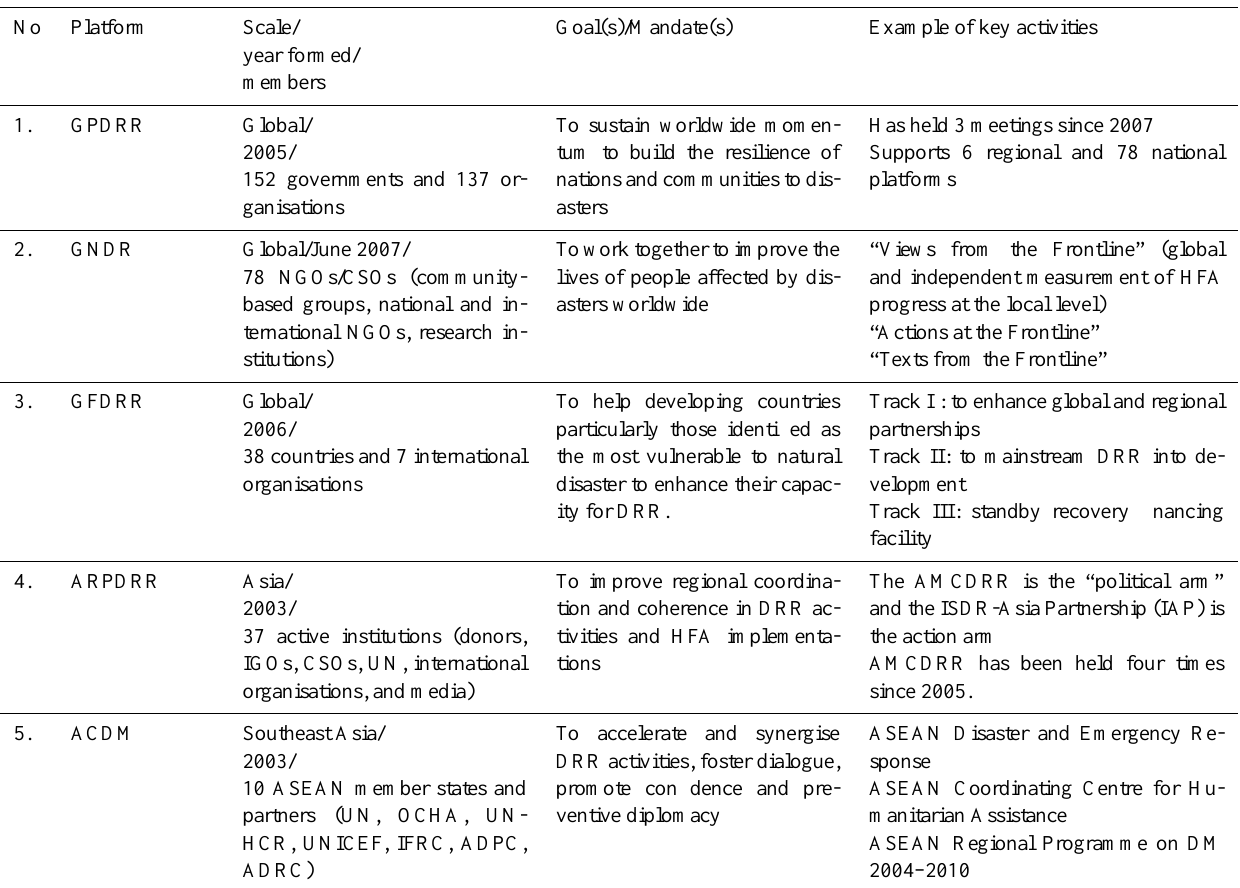
Table 2. Multi-stakeholder platforms for disaster risk reduction from a global to a local level. No